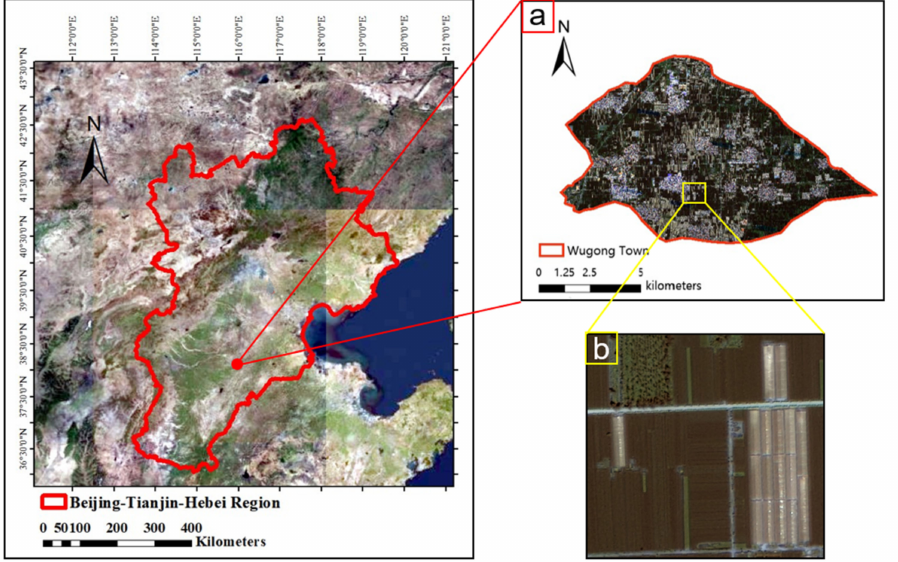
Figure 1. Overview of the study area. ( a ) the study area Wugong Town. ( b ) the fragment of the study area with